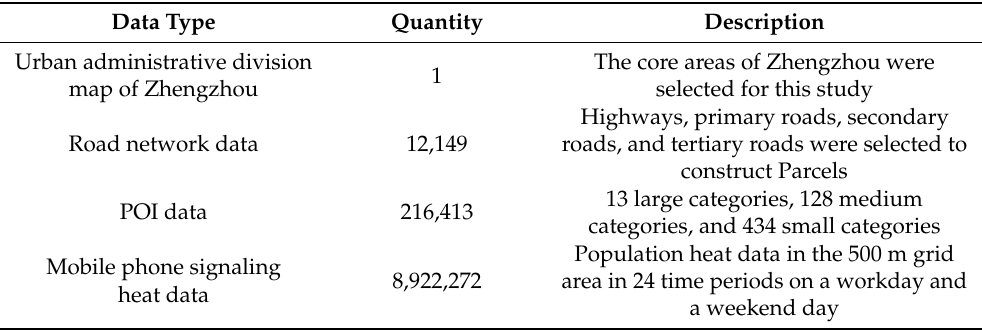
Table 1. Data used in this study.